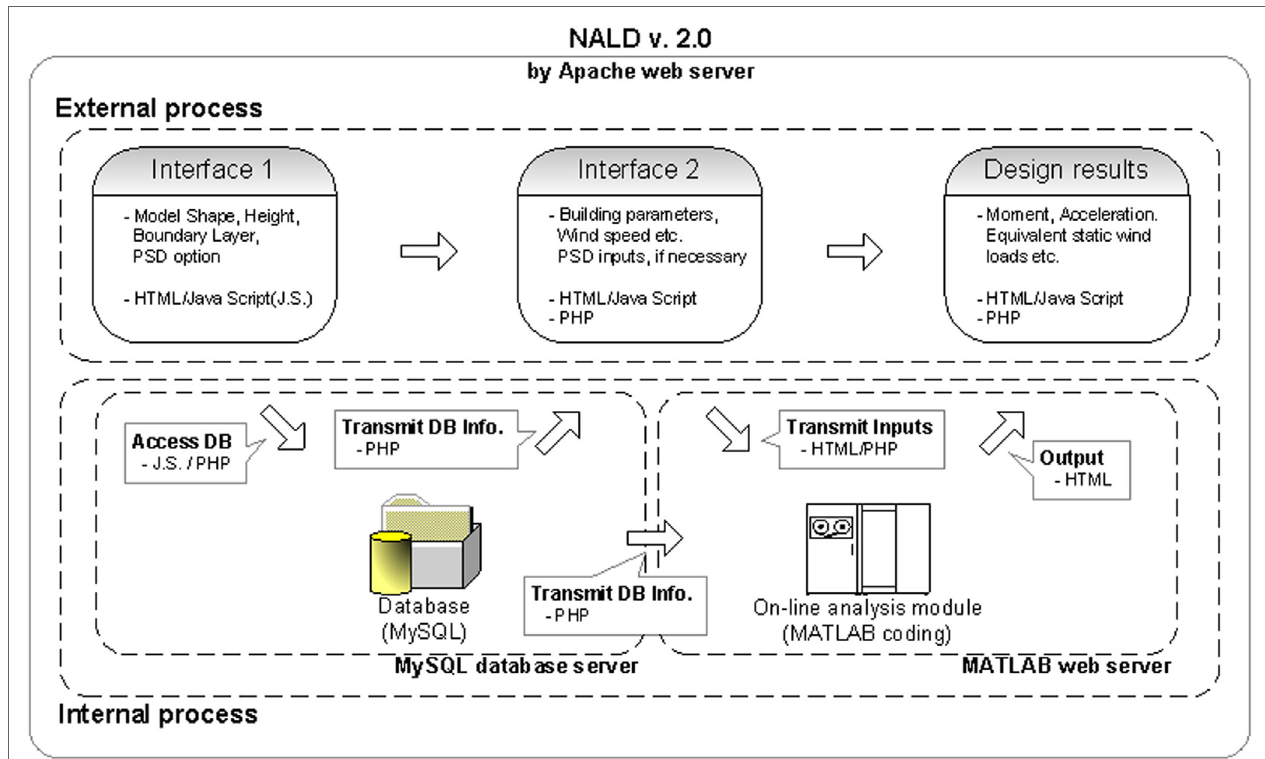
FigUre 4 | Schematic diagram of NatHaz aerodynamic loads database ver. 2.0